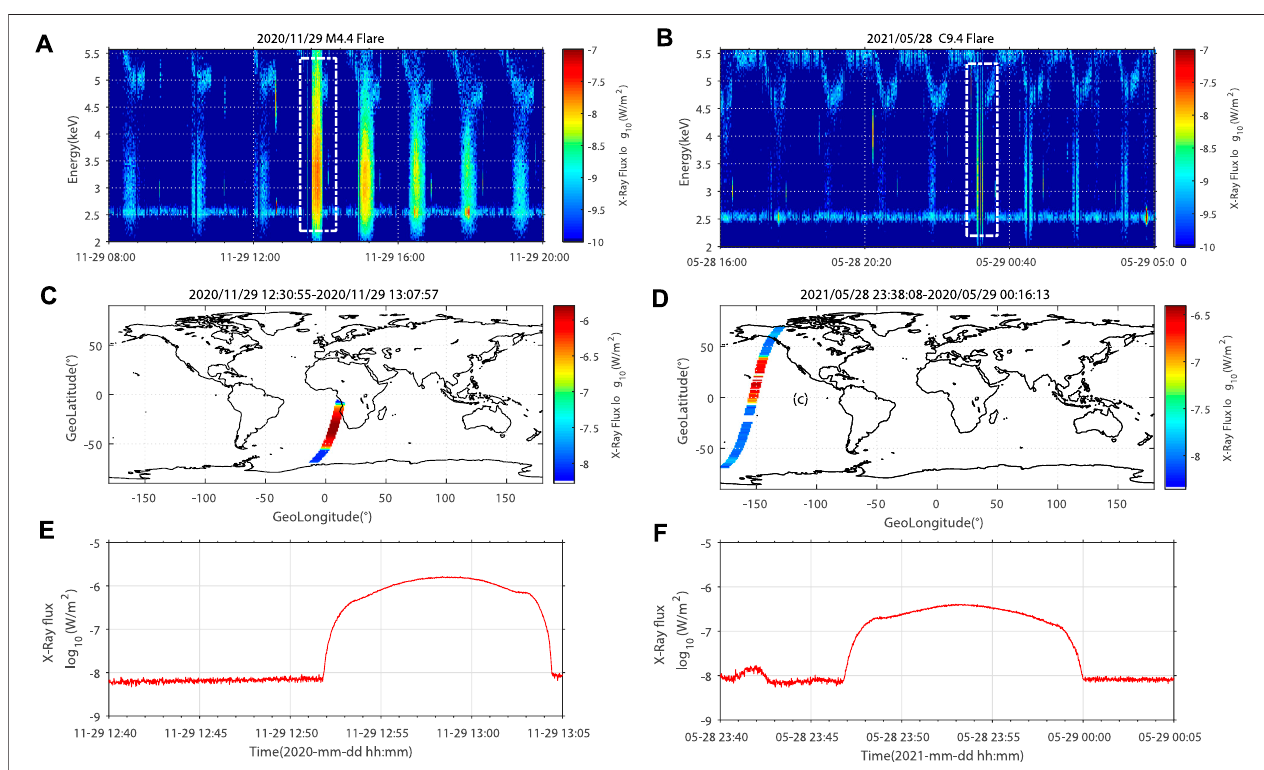
FIGURE 1 | X-ray fl uxes before the two SPEs measured by HEPP-X. (A,C,E) The M4.4 fl are fl ux distribution before 2020 gradual SPE. (B,D,F) The C9.4 fl are fl ux distribution before 2021 impulsive SPE.